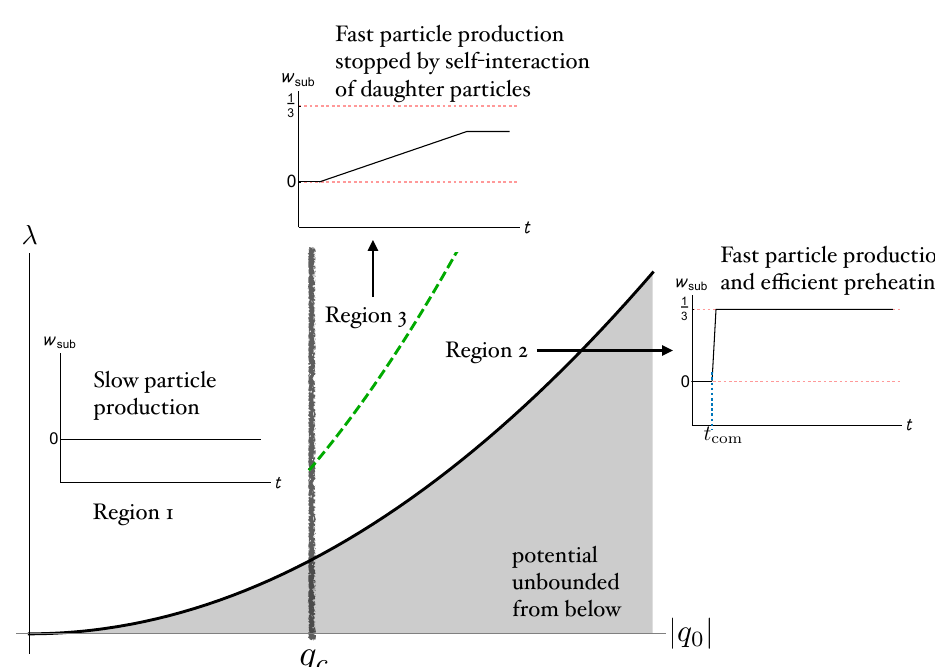
Figure 4 . Schematic phase diagram of the spectator tachyonic resonance mechanism in the pa- rameter space ( q 0 , λ ) . w sub = p sub /ρ sub defined for the (sub-)system of σ and ψ . The black curve (cid:16) (cid:17) 2 2 m σ corresponds to λ = q , below which the potential is unbounded. The green dashed curve 0 8 σ 0 corresponds to a large enough λ , which leads to a large positive λ h ψ 2 i ψ 2 to stop particle production and separates region 2 and